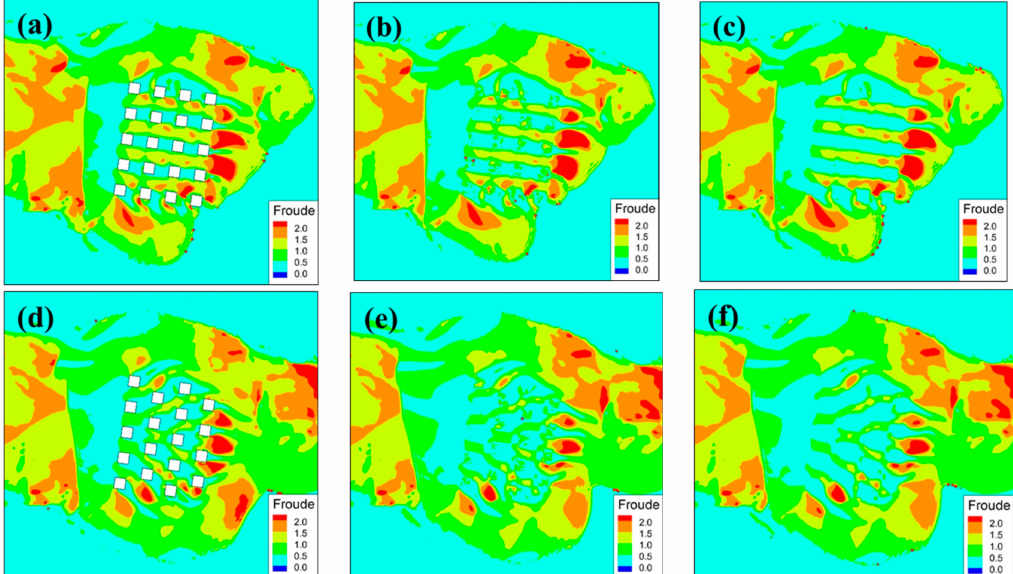
Figure 13. Froude number after 15 s with aligned and staggered layouts: ( a , d ) are in BH method; ( b , e ) are in BB method; ( c , f ) are in BR method; ( a – c ) are in aligned layout; ( d – f ) are in staggered layout.